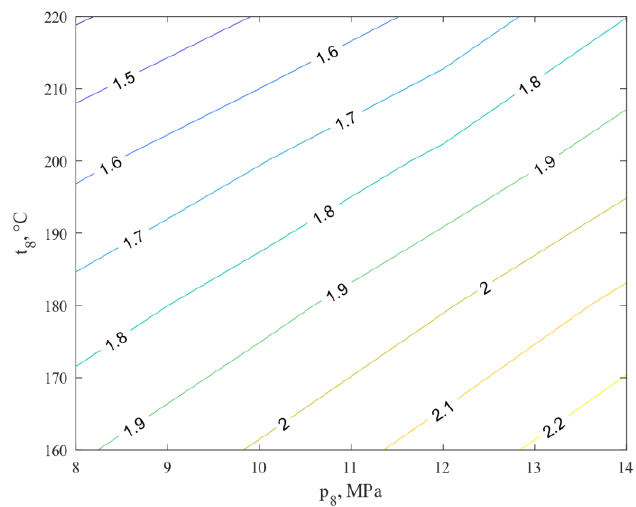
Figure 6. Influence of changes in pressure, p 8 , and temperature, t 8 , at the reactor inlet (Figure 3) on the total amount of heat from the exchangers HX1, HX2, and HX3 ( 𝑄̇ 𝐻𝑋1 , 𝑄̇ 𝐻𝑋2 , 𝑄̇ 𝐻𝑋3 , in kW.